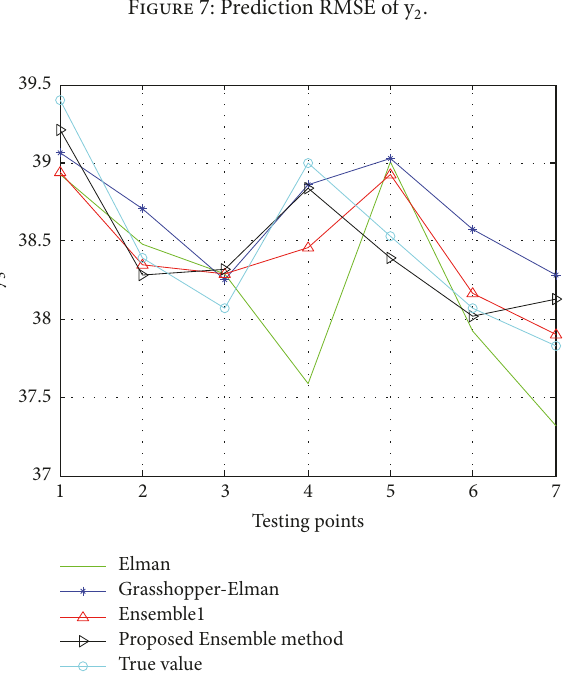
Figure 7: Prediction RMSE of y 2 .